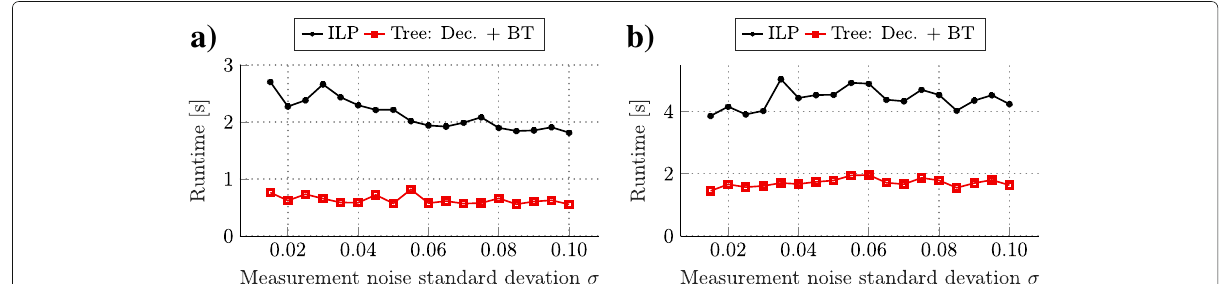
Fig. 9 Figures a and b show the total run times for 10 DS-CDMA codes in the case of N = 40 agents and 20 CD-CDMA codes for N = 80 agents. Moreover, the sensing range has been set to R = 0.2